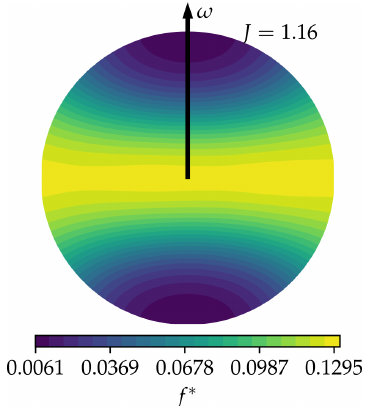
Figure 9. Pole figure for W → ∞ and T = − 5 ◦ C at steady state. A very weak girdle fabric is produced, with the girdle coincident with the axis of vorticity, shown by an arrow. This fabric has a J index of 1 . 16, where J = 1 is an isotropic